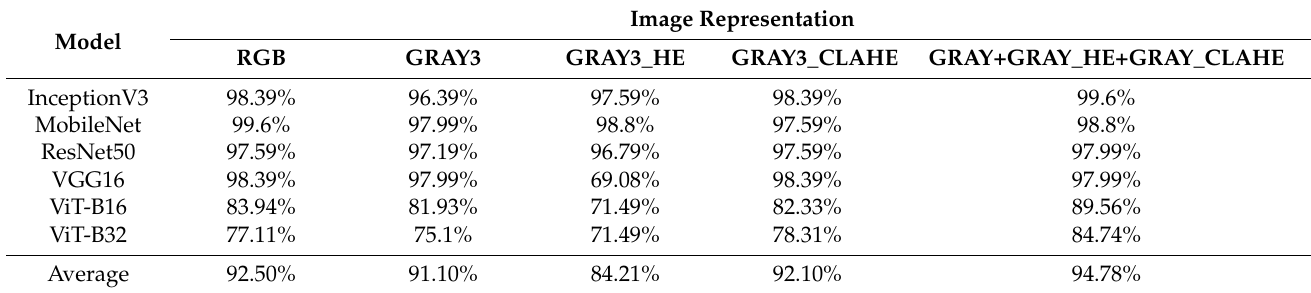
Table 3. Accuracy of the models across various image representations.